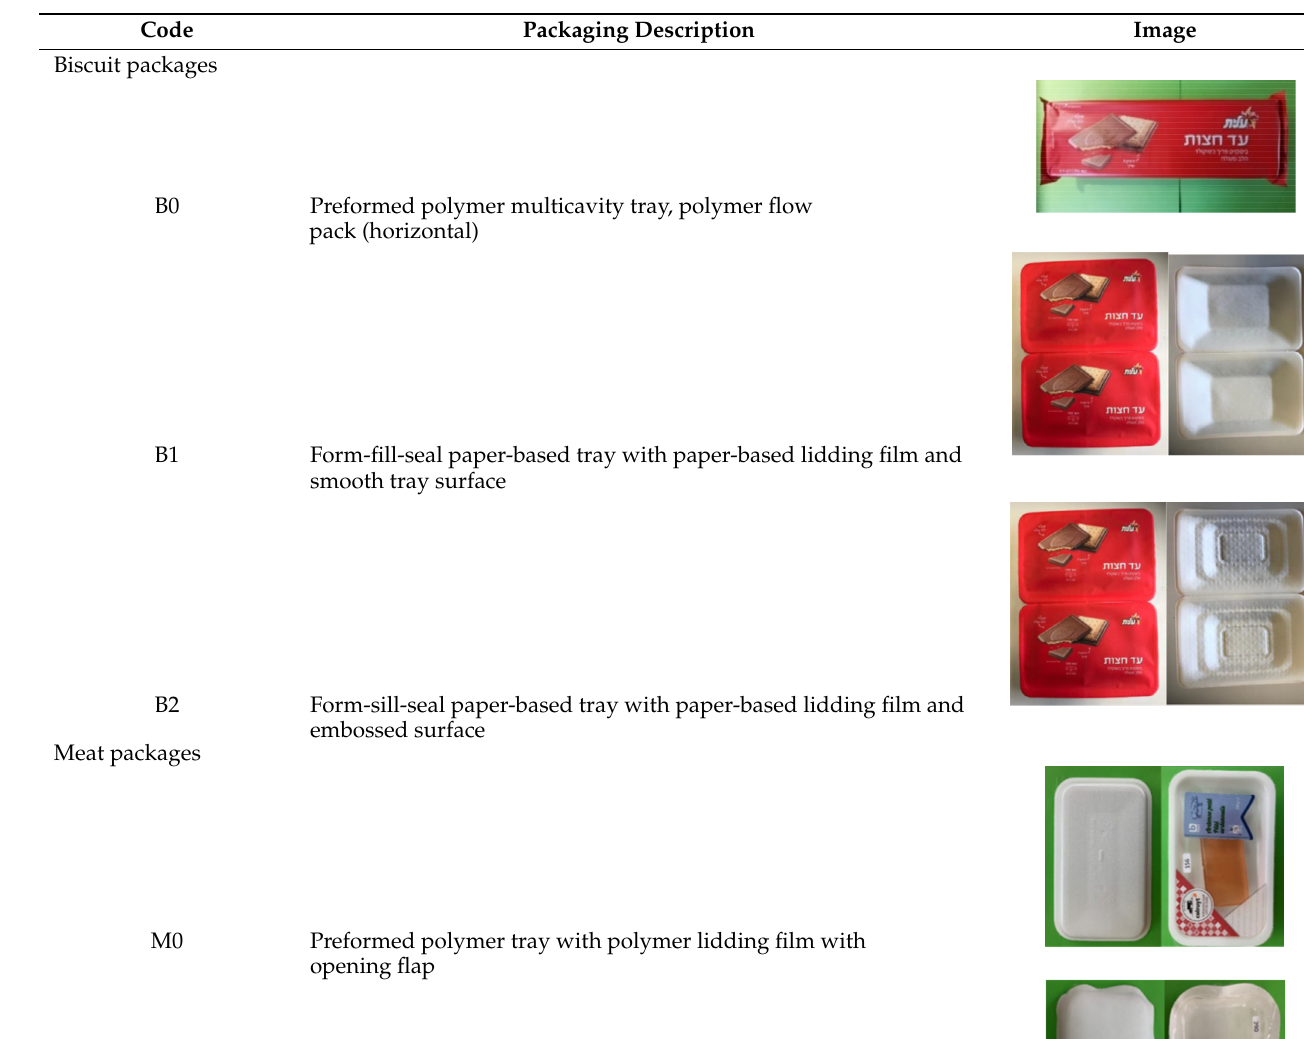
Table 1. Biscuit and meat packages discussed in Stage